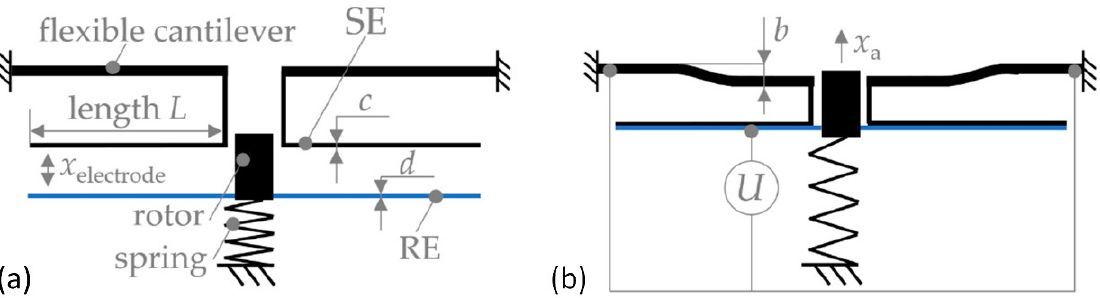
Figure 9. Bending plate actuator: ( a ) initial configuration of the actuator, ( b ) completely pulled-in bending plate actuator, x a —maximum displacement of the actuator. Adapted from [84].